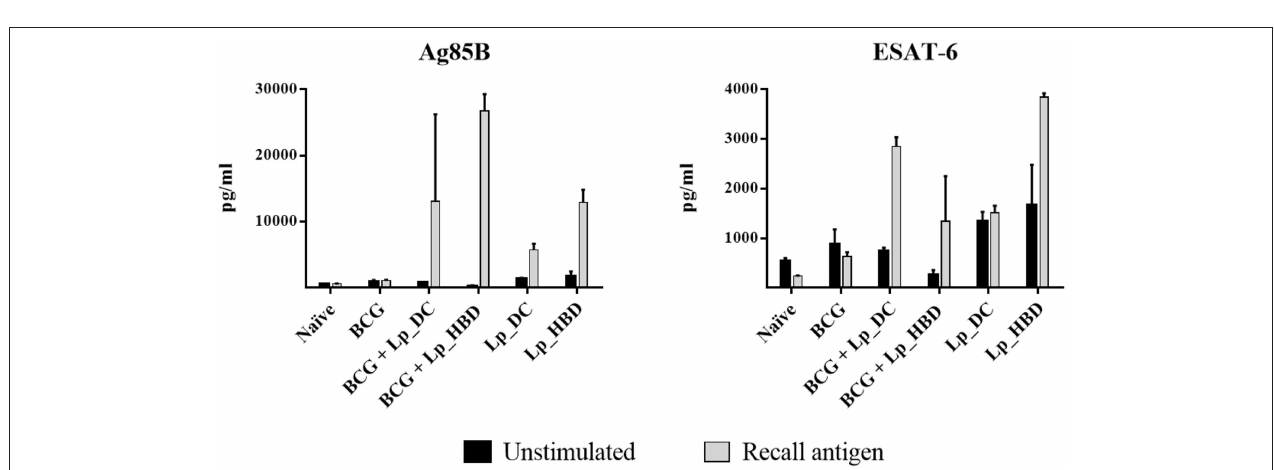
FIGURE 7 | IFN- γ secretion induced by recall antigens in proliferating splenic T cells. Splenocytes from immunized mice were stimulated with Ag85B or ESAT-6 for 6 days and levels of IFN- γ were quantified by ELISA. Results are presented as a mean ± SEM of technical duplicates and are from pooled spleens ( n = 2–3).